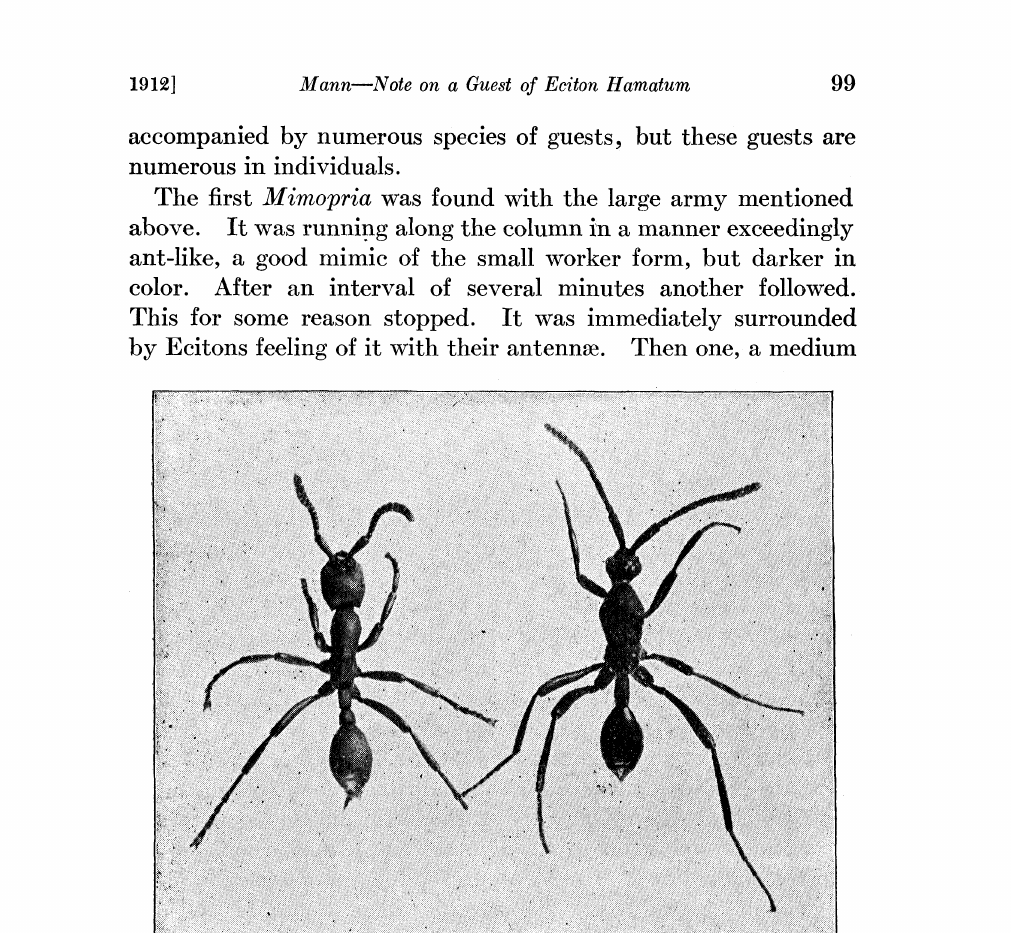
Fig. 1. Eciton hamatum Fabr. (small worker), and guest, Mimopria ecito- nophila Holm. sized worker, seized it by the thorax and resumed the march with the Mimopria extending backward beneath its